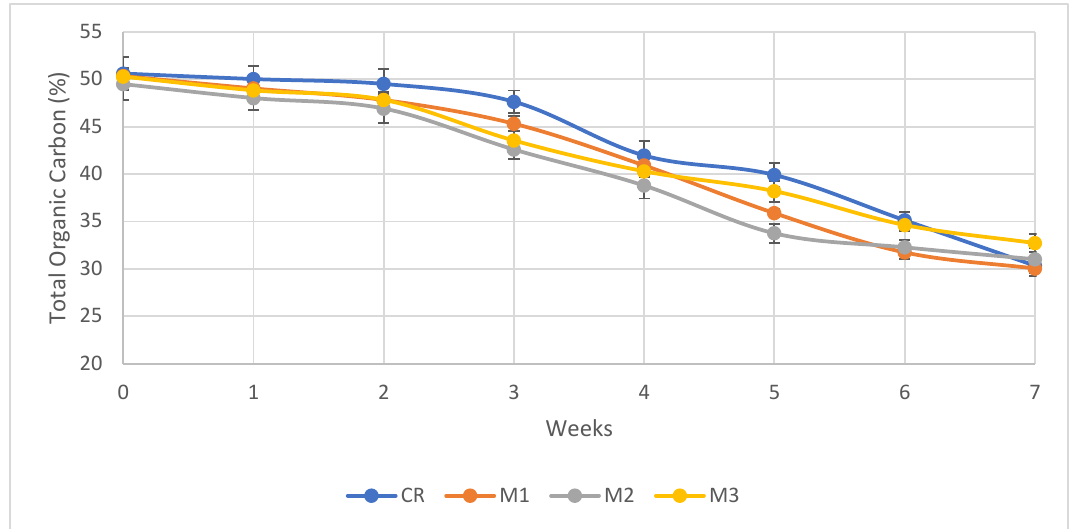
Figure 10. Total organic carbon behavior in mixtures (CR, M1, M2 and M3) during vermicomposting process.